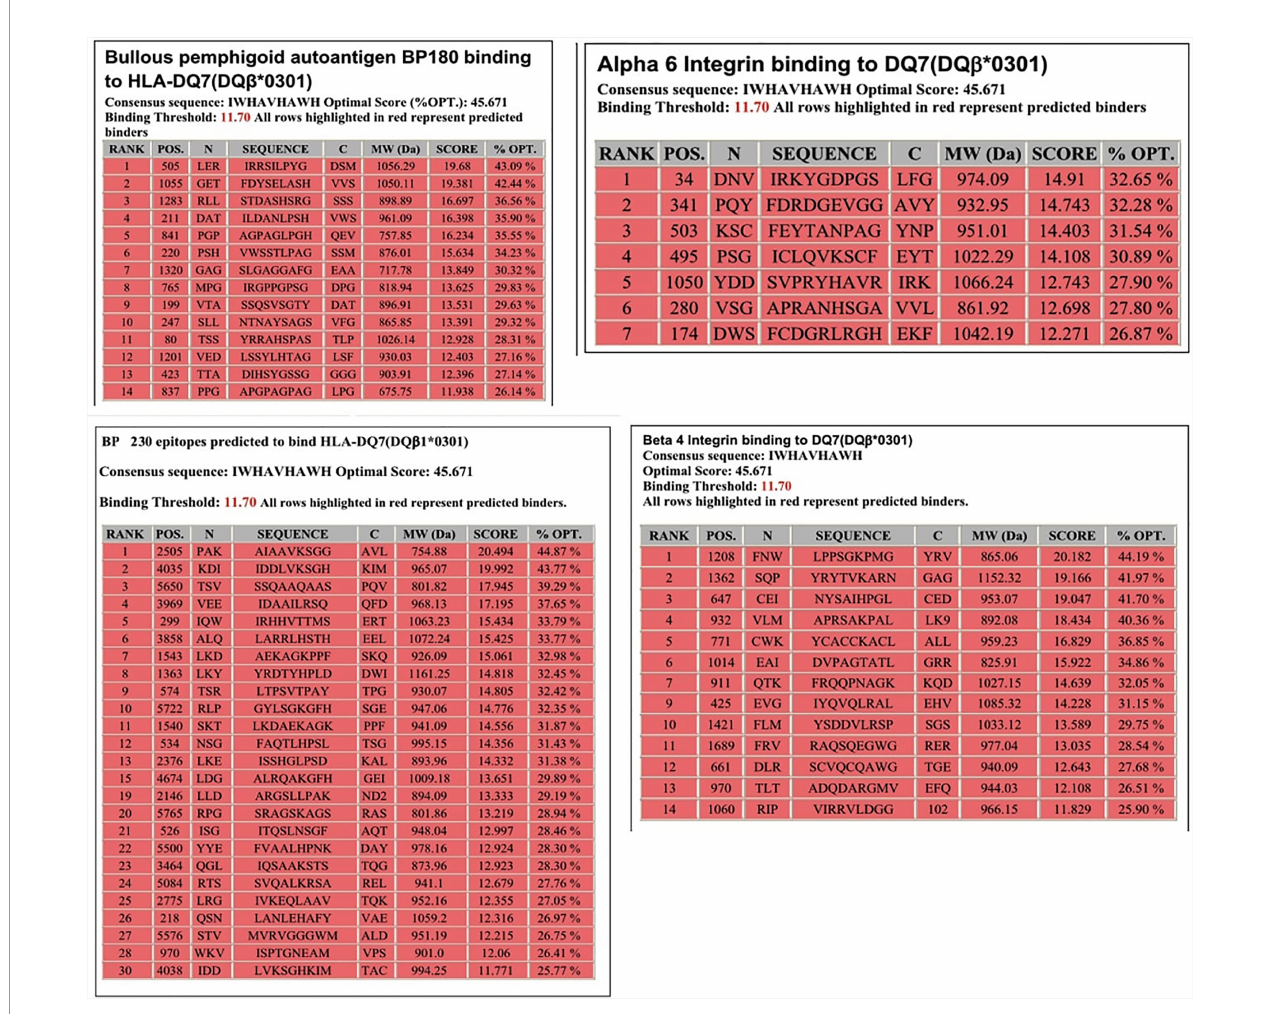
FIGURE 1 | Potential HLA – DQ7 (DQ b 1*03:01)-binding peptides in BPAG1, BPAG2, human b 4 integrin, and human a 6 integrin. Obtained from our previous publication. Autoimmunity Reviews 2011;11:40-47. With permission of the